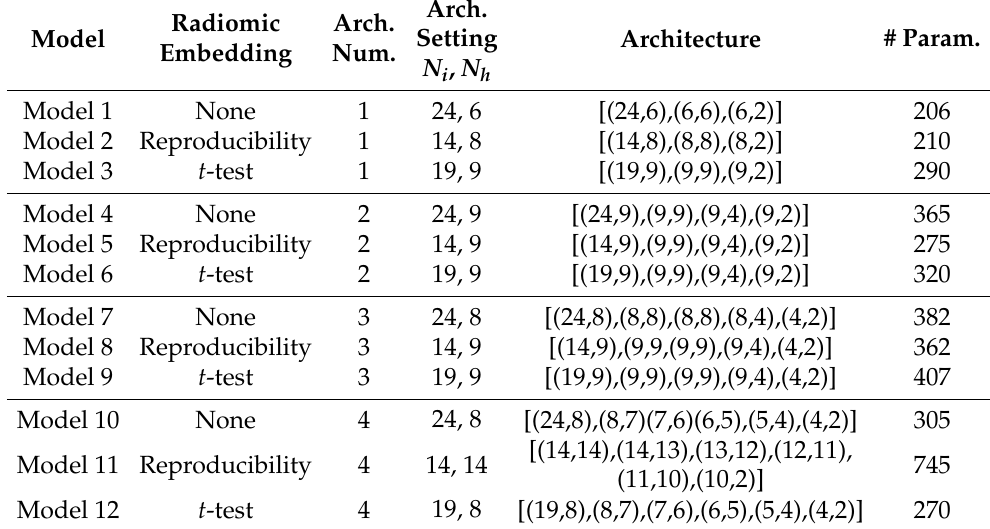
Table 6. Architecture of best models.